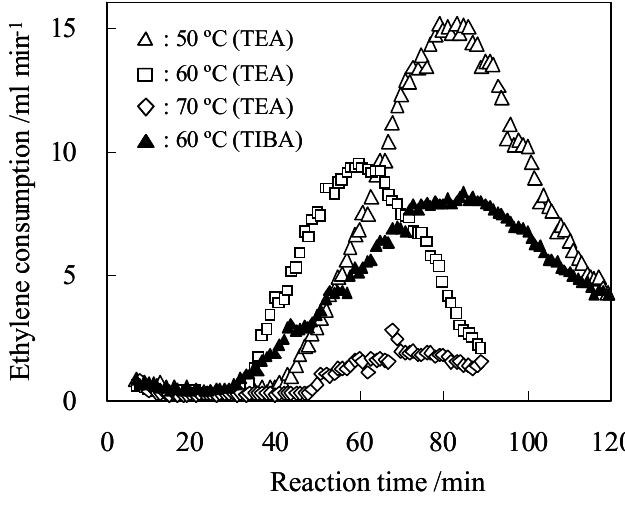
Figure 5. Profiles of ethylene consumption from ethylene oligomerization at 50–70 °C using L3 /Ni 2+ -Mica procatalyst. Reaction conditions are the same as in Table